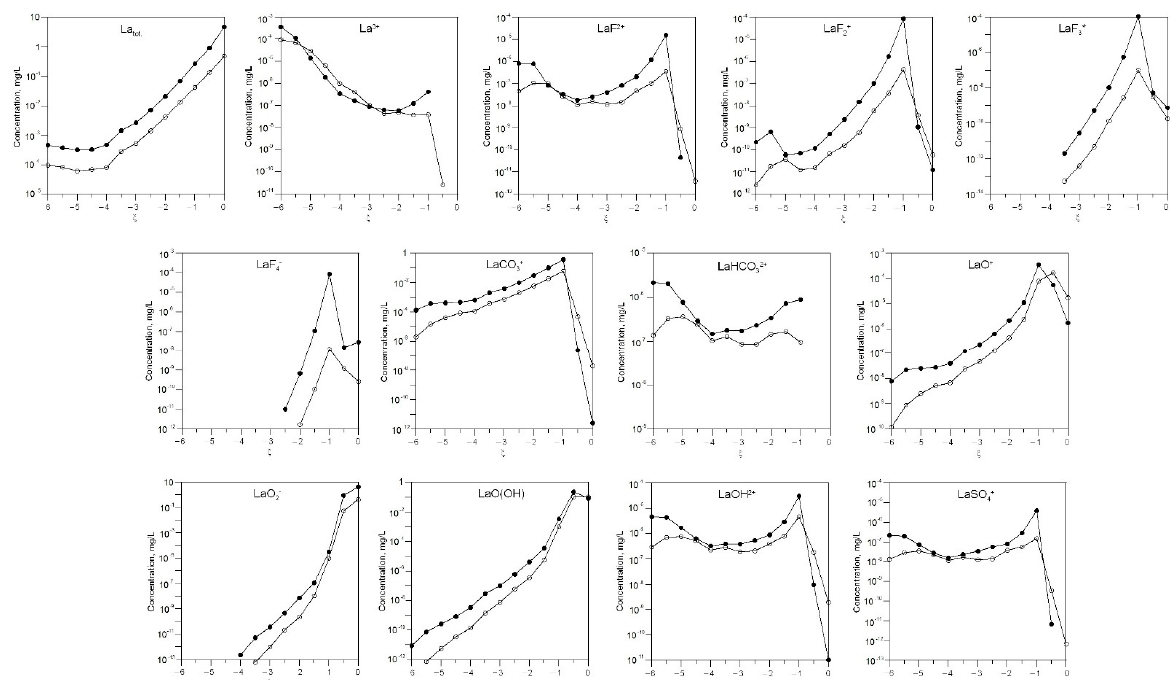
Figure 6. Change in the concentration of the dissolved forms of lanthanum in the solution depending on the degree of interaction ξ and 0.05 L (white) and 0.01 L (black) of water in the system.